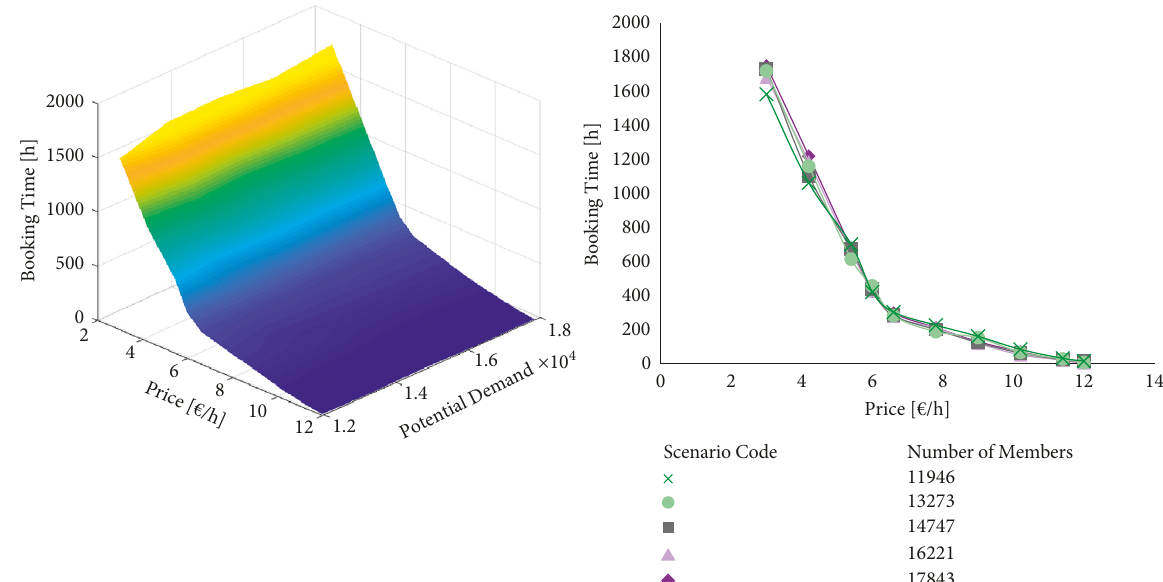
Figure 7: Demand elasticity.